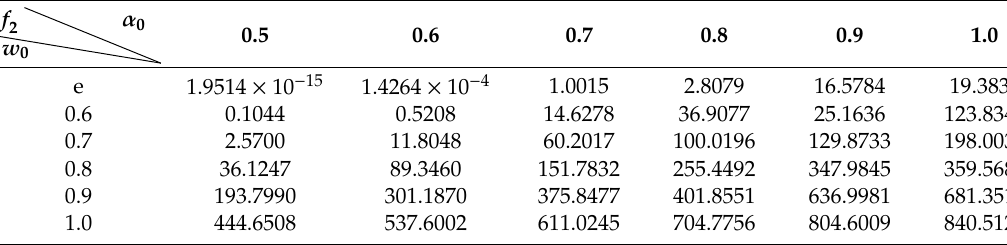
Table 4. The influence of w 0 and α 0 values on f 2 optimization results.